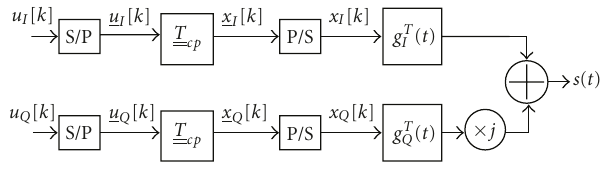
Figure 4: O ff set QPSK block